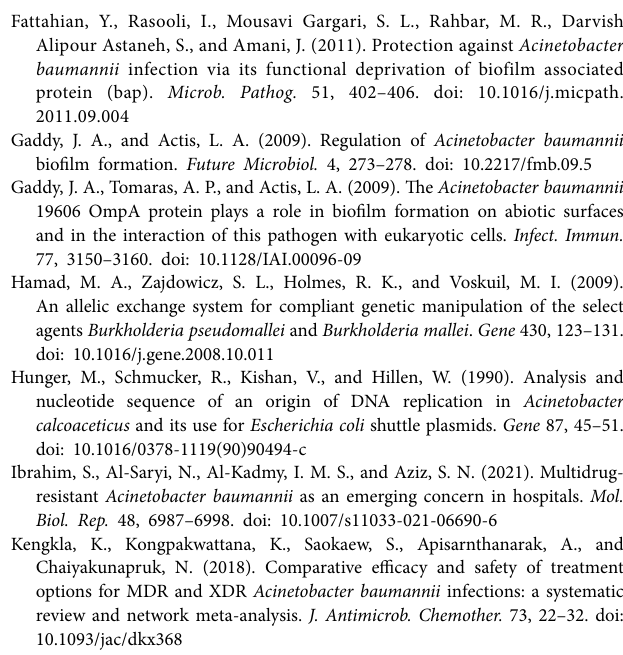
Supplementary Figure S1 | Phylogenetic analysis of BIT33_RS14560 gene. Bootstrap values >50 are displayed on the branches. A higher bootstrap value indicates a better reliability. Supplementary Figure S2 | Phylogenetic analysis of BIT33_RS14560 protein. Bootstrap values >50 are displayed on the branches. A higher bootstrap value indicates a better reliability. Supplementary Figure S3 | The construction of p-RS14560 overexpressed vector. (A) The amplification of BIT33_RS14560 fragment. Lane 1: DNA marker 2,000 bp, lane 2: sample; (B) PCR products of pWH1266 plasmid as negative control. Lane 1: DNA marker 2,000 bp, lane 2: PCR products of pWH1266 plasmid as negative control (C) Recombinant plasmid is successively transformed into competent E. coli DH5 α and ATCC 19606 strains, with the Pwh1266-F/ Pwh1266-R primers being used to ensure the success of directional linkage. Lane 1: DNA marker 2,000 bp, lane 2: PCR products of p-RS14560 plasmid as positive control, lane 3: PCR products of positive clone. Supplementary Figure S4 | A representative part of the sequence alignment between the target gene in the p-RS14560 vector and the comparative analysis to the BIT33_RS14560